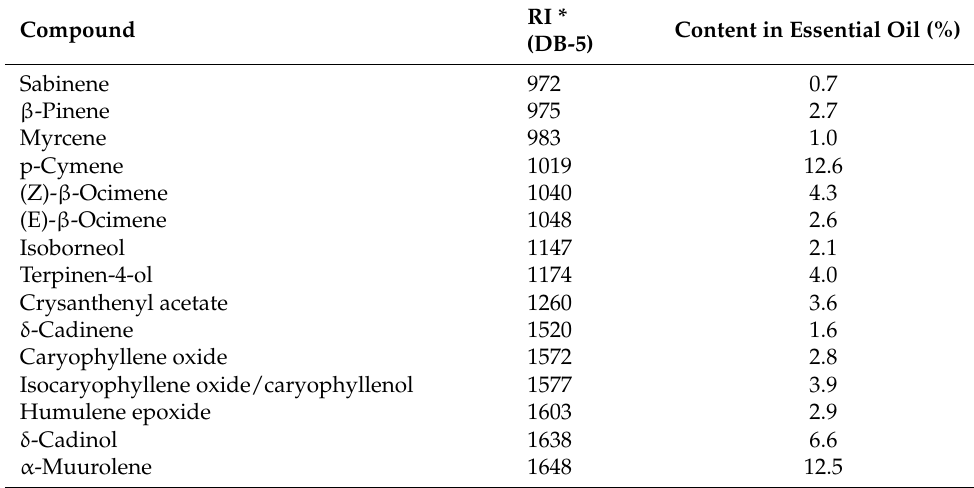
Table 1. Essential oil content of aerial parts of Anthemis tinctoria